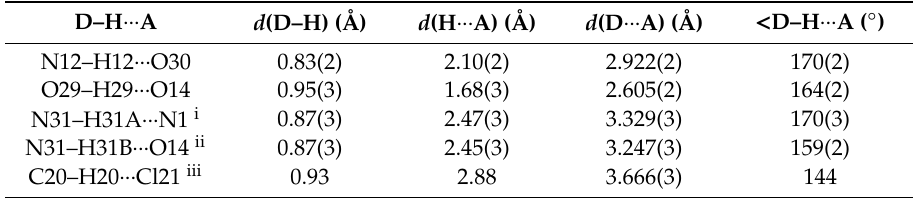
Table 3. Hydrogen bonding interactions in the crystal structure of chlordiazepoxide co-crystals with p -aminobenzoic acid.